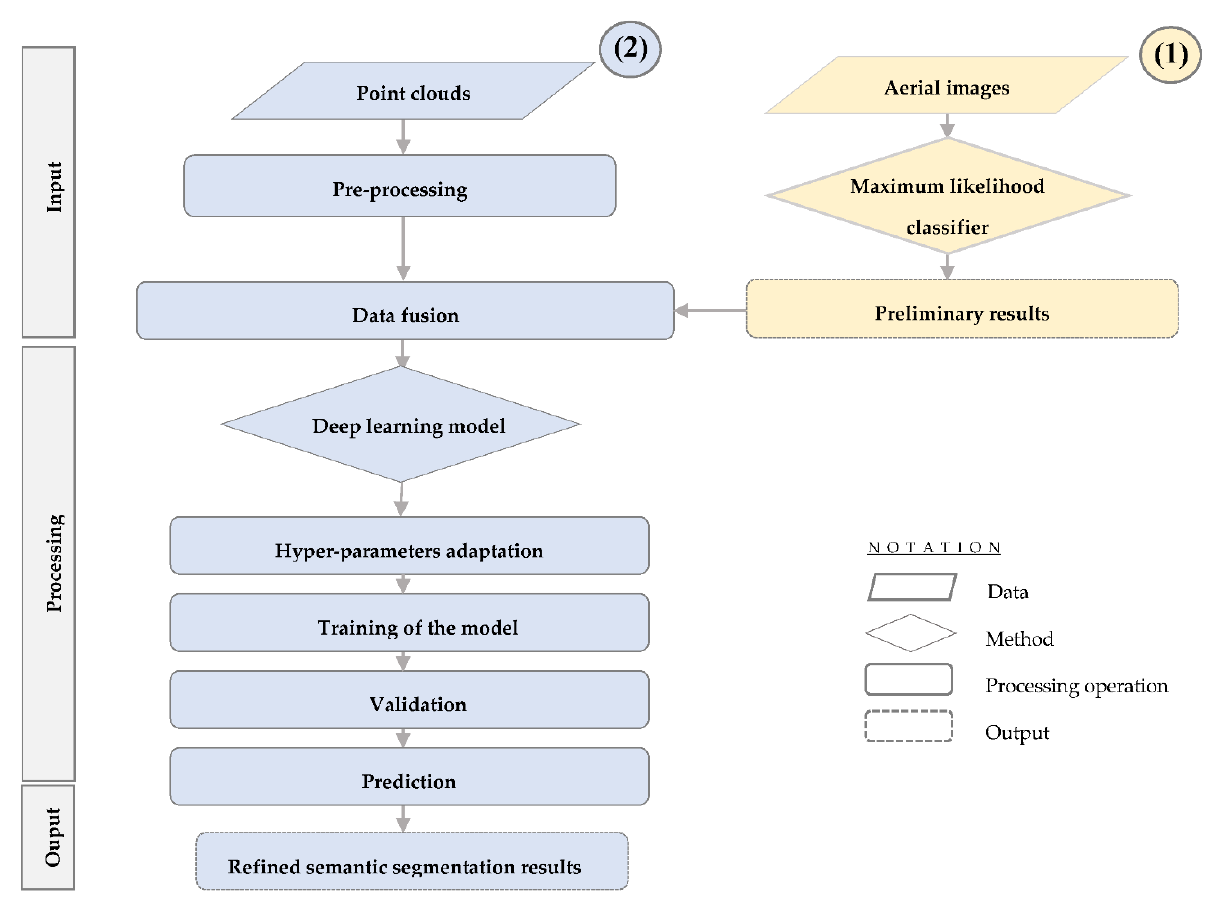
Figure 4. The general workflow of the proposed approach.